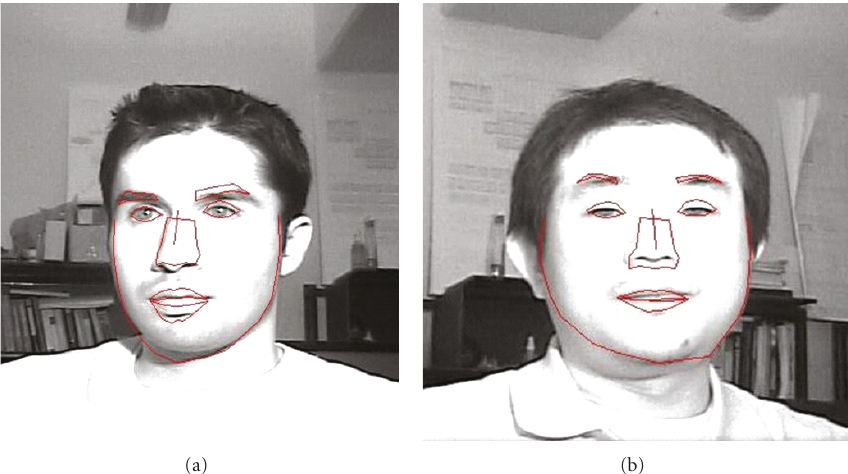
Figure 14: Active shape model fitting for two users of the system. The position of the eye can be read o ff from the keypoint locations around the eye (see Figure 13). The center of the eye is taken as the center of mass of these keypoints.